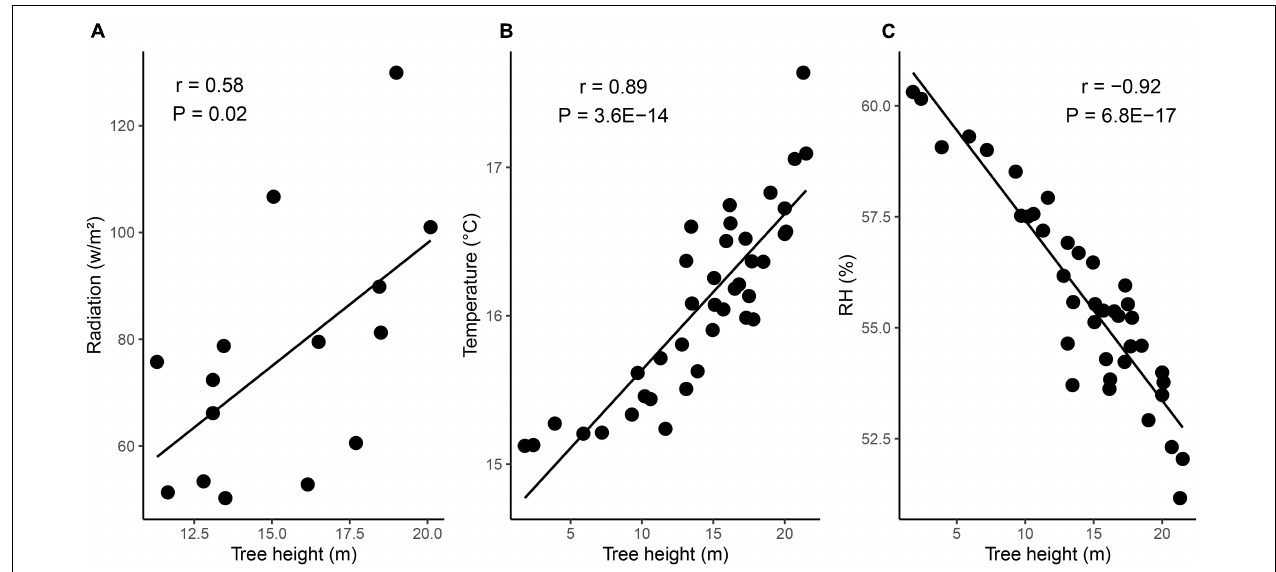
FIGURE 3 | Regression plots showing how radiation (A) , temperature (B) and RH (C) changes with height in the